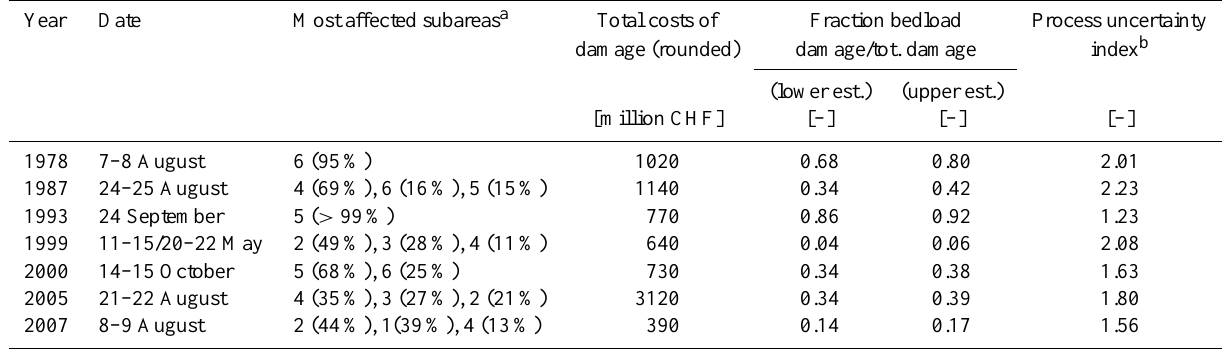
Table 3. The impact of bedload transport processes for damage costs during seven major flood events in Switzerland (since 1972).